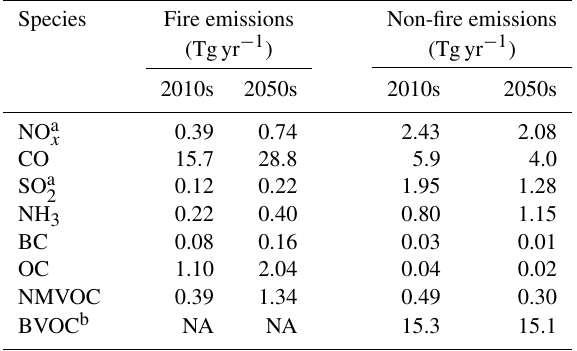
Table 2. Emissions from wildfires and non-fire sources over boreal North